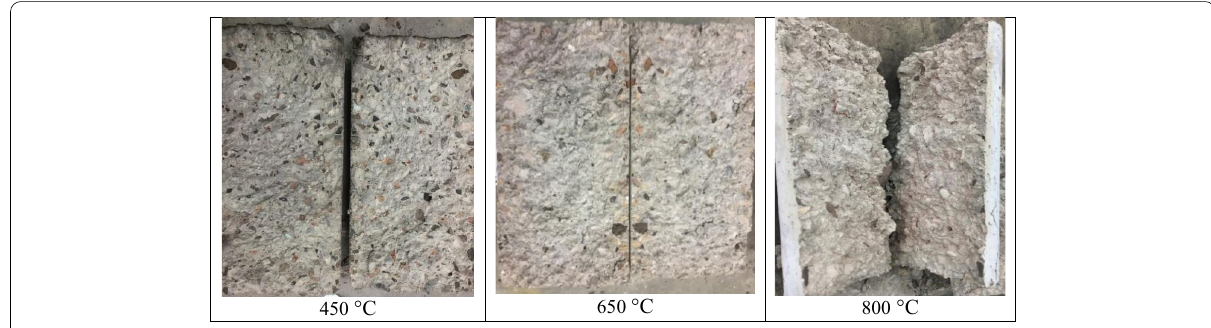
Fig. 9 Failure modes of fractured surfaces.